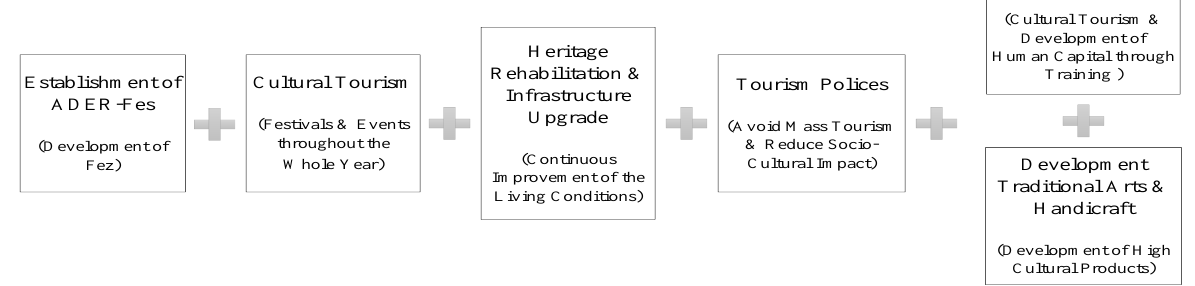
Figure 6 Fez key steps to achieve tourism sustainability (Adapted by the